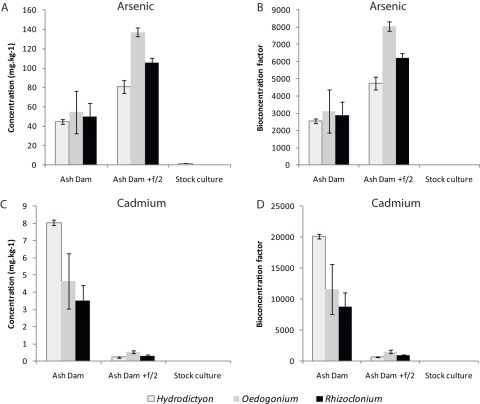
Examples of patterns of concentration and bioconcentration of metals in algae when cultured in Ash Dam water, Ash Dam water with f/2 and the stock cultures.(A) Concentration of arsenic. (B). Bioconcentration of arsenic. (C) Concentration of cadmium. (D) Bioconcentration of cadmium.